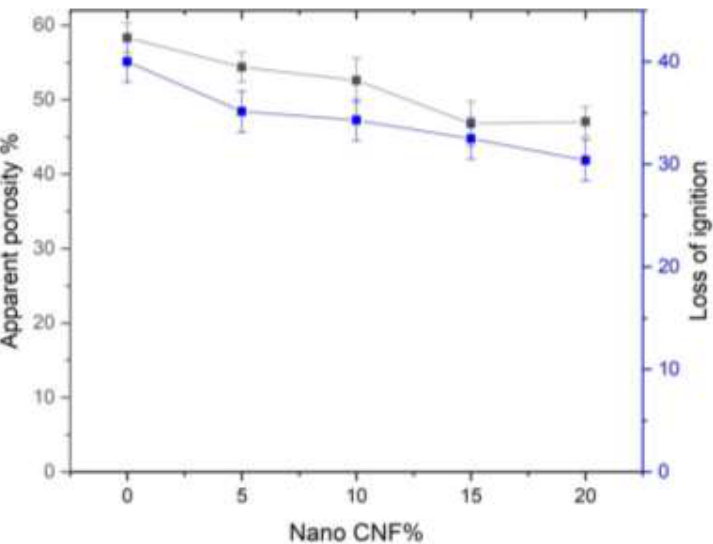
Figure 4: Effect of (CNF) ratios on the porosity and loss of ignition for specimens.